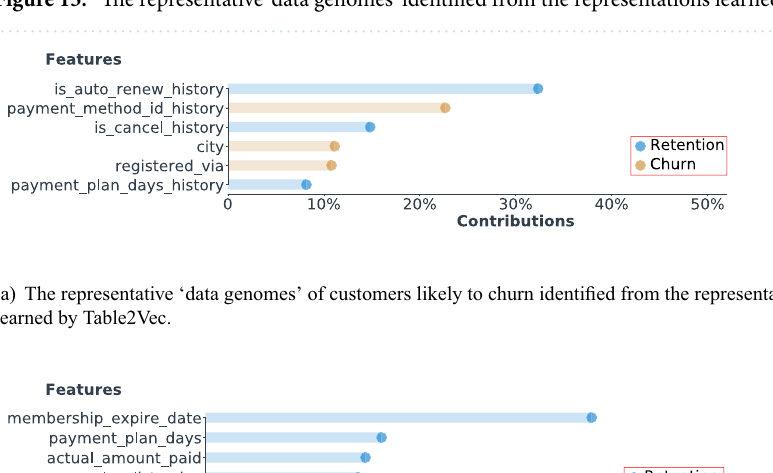
(a) The retention-sensitive representative ‘genomes’ identified from the (b) The churn-sensitive representative ‘genomes’ identified from the representations learned by Table2Vec. representations learned by Table2Vec. Figure 15. The representative ‘data genomes’ identified from the representations learned by Table2Vec.